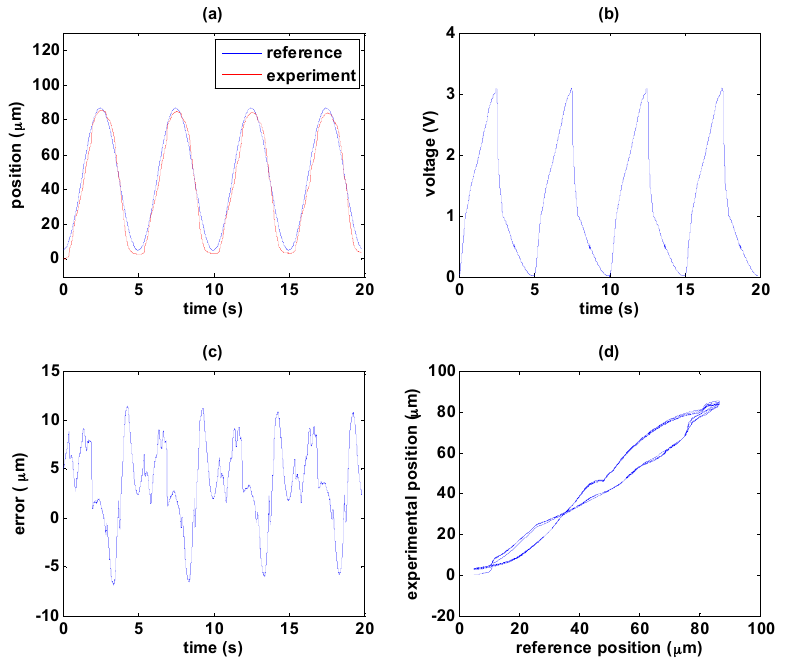
Figure 11. Path tracking of sinusoidal wave by the hysteresis compensator: ( a ) path tracking responses; ( b ) control signals; ( c ) control errors; ( d ) linear relationship between reference and experimental positions.